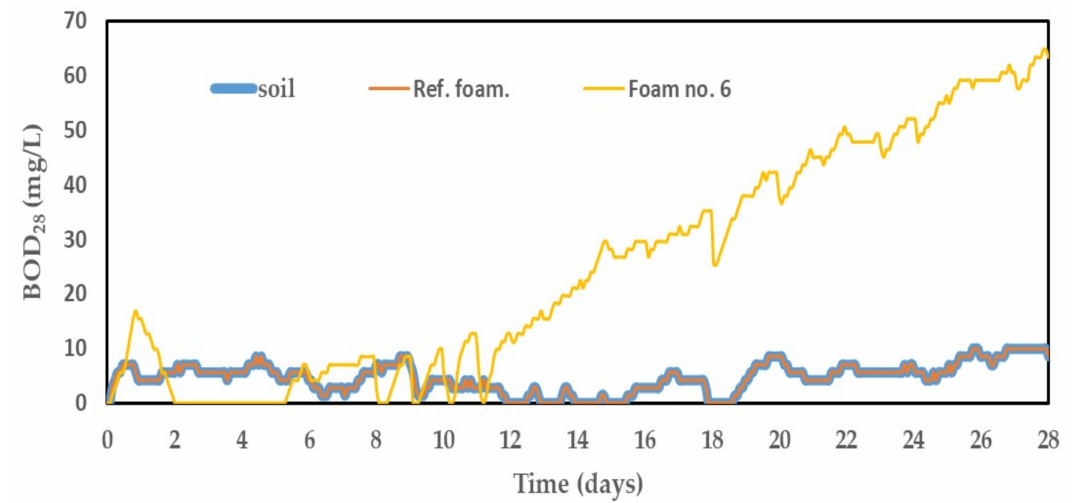
Figure 9. Results of biochemical oxygen demand of foams during measurement.